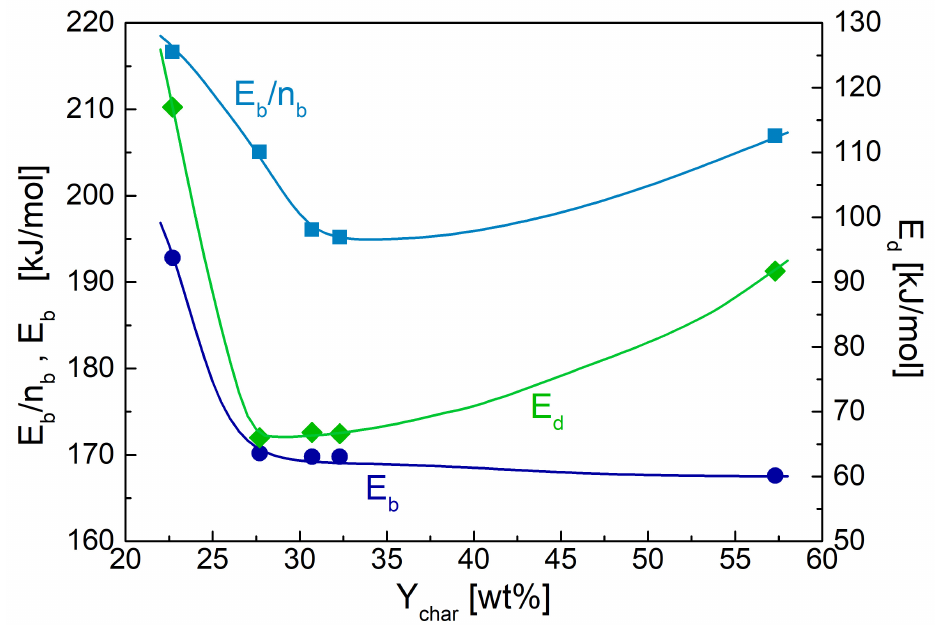
Figure 5. Activation energies of the devolatilization reaction, E d , and the oxidation reaction, E b , and ratio E b /n b (n b reaction order) versus the torrefaction degree expressed in terms of pyrolysis char yield, Y char .